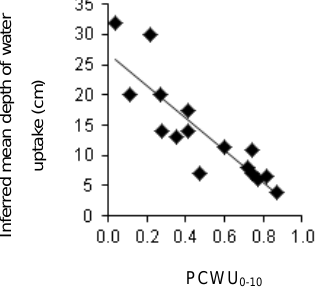
Figure 3. Correlation between the proportional contribution to water uptake of the 0-10 cm soil depth interval (PCWU 0-10 ) with the inferred mean depth of water uptake (r = 0.86)